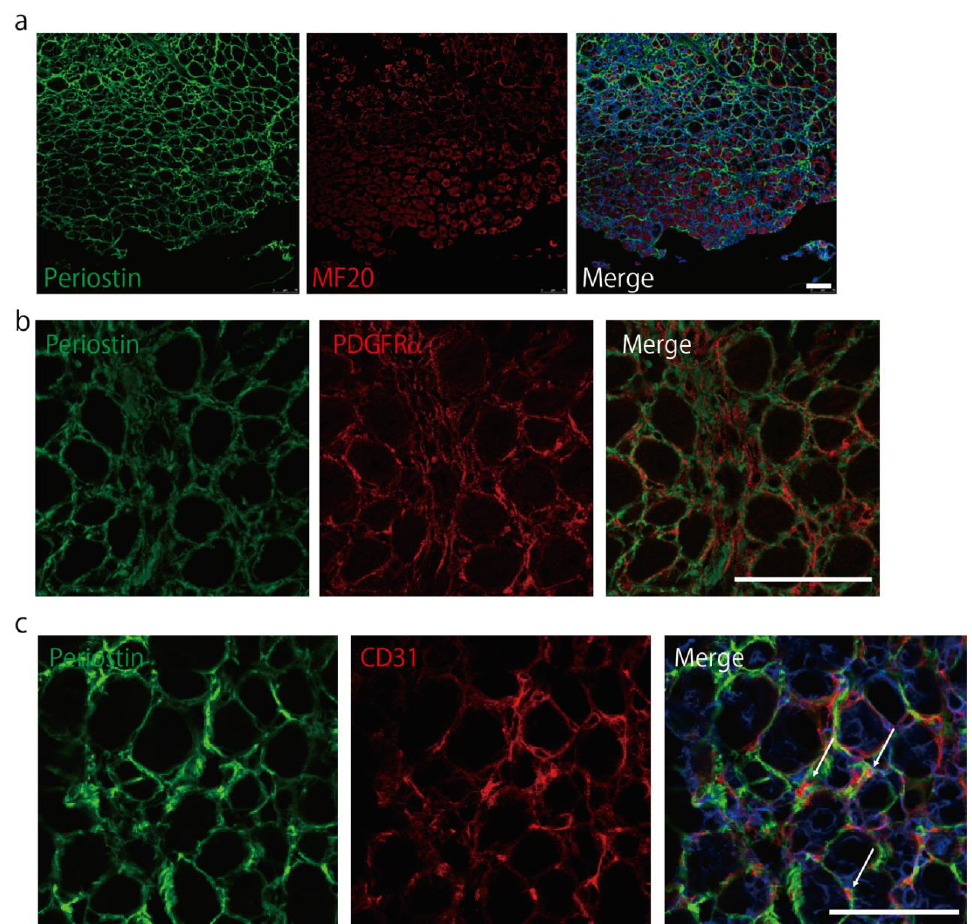
Figure 3. Periostin is expressed in the interstitial space during muscle regeneration. ( a ) Immunostaining of periostin (green) with MyHC (MF20, red) 5 days after the induction of muscle regeneration. Bar: 75 μm. ( b ) Immunostaining of periostin (green) and PDGFRα (red) 5 days after the induction of muscle regeneration. Bar: 75 μm. ( c ) Immunohistochemical images of periostin (green) with CD31 (red) 7 days after the induction of muscle regeneration. Arrows indicated the CD31 signals surrounded by periostin. Bar: 75 μm. n = 3. Error bars indicate SEM.